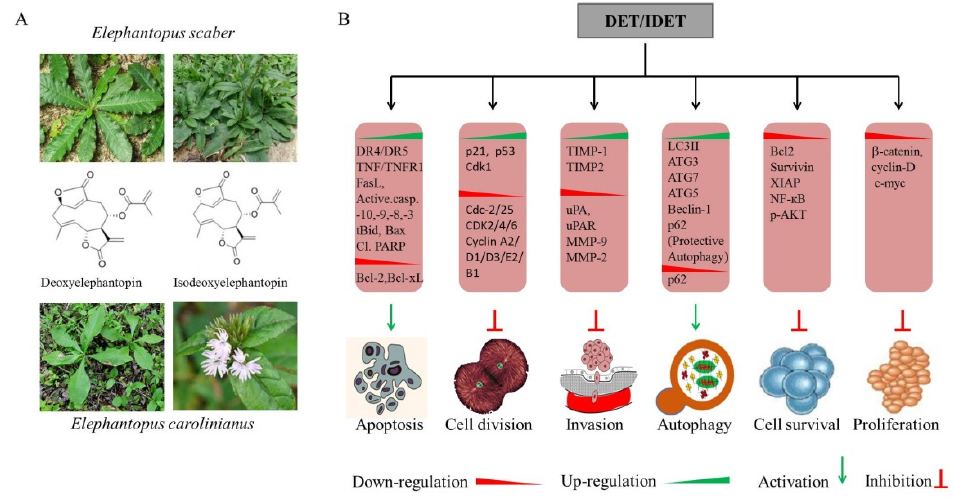
Figure 1. Deoxyelephantopin (DET) and isodeoxyelephantopin (IDET) ( A ): Chemical structure and natural sources of DET and IDET. ( B ): DET/IDET inhibits cancer progression and development by inhibiting cancer cell proliferation, survival, invasion, and cell cycle progression, and ultimately induces apoptosis and autophagy by modulating the expression of various genes.